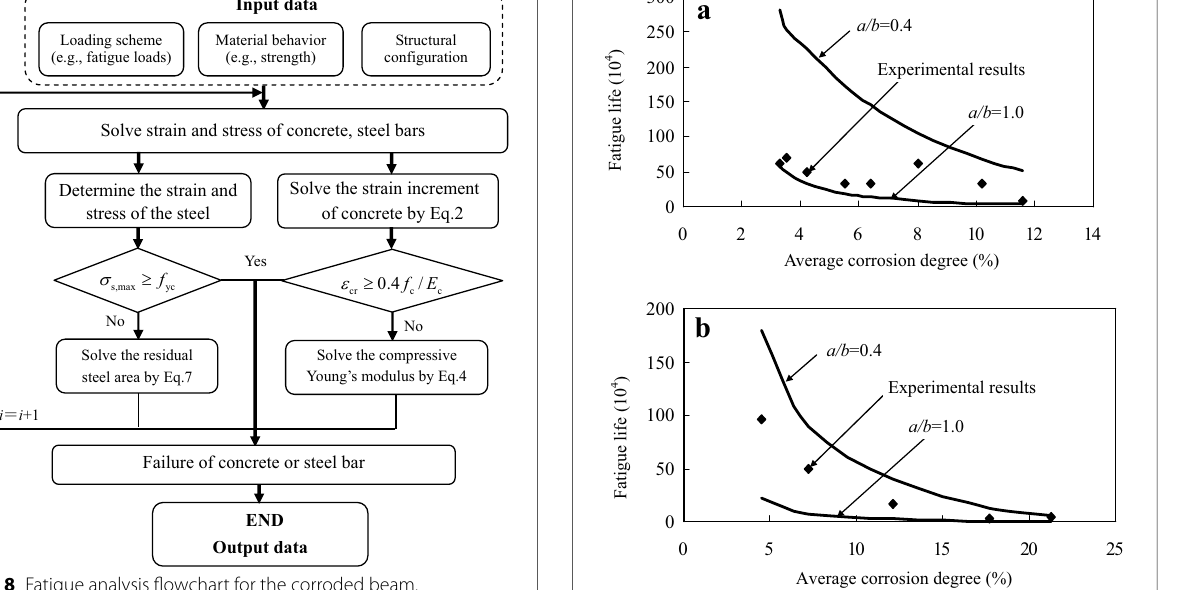
Fig. 9 Fatigue life comparison of experimental and FPM results: a Yi’test, b this test.